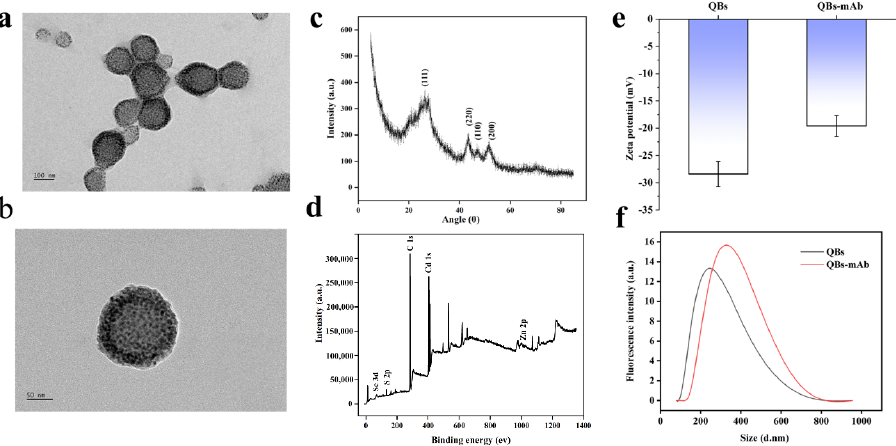
Figure 1. Characterization of QBs and QBs-mAb. ( a ) High-resolution TEM image of the QBs. ( b ) Individual QB at high magnification. ( c ) XRD patterns of QBs, ( d ) XPS survey of QBs, ( e ) zeta potential of QBs before and after coupling with mAb. ( f ) Size distribution of the hydrodynamic diameter of QBs and QBs-mAb.